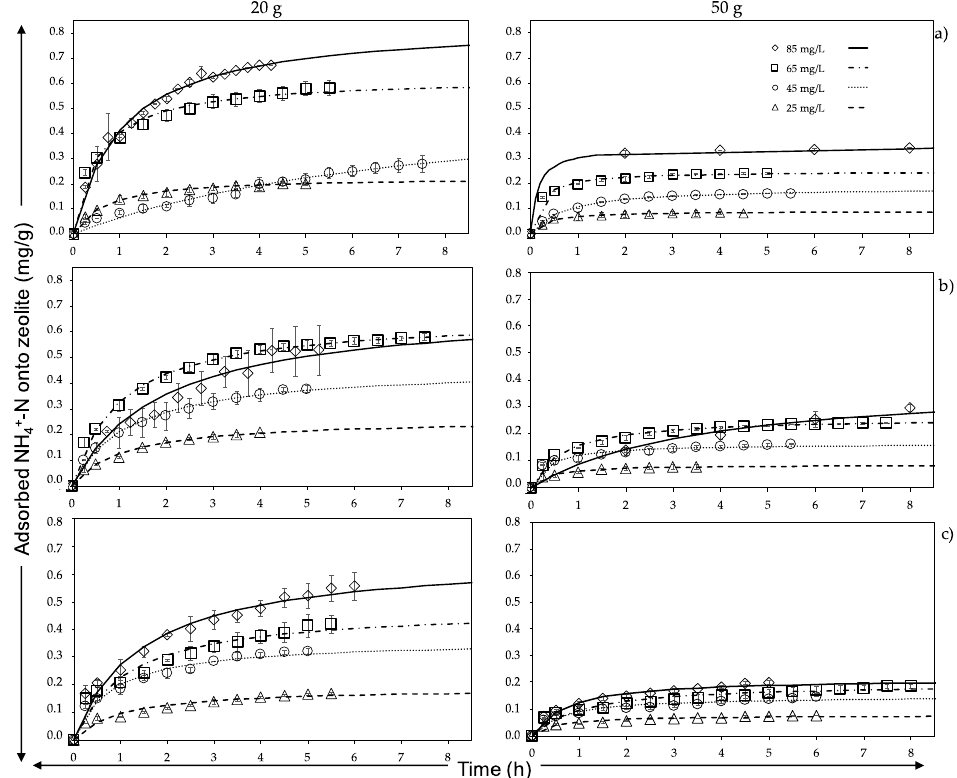
Figure 1. Adsorbed ammonium (mg / g) onto zeolite vs. time in batch assays for the determination of adsorption characteristics. Particle size: ( a ) 5.0–8.0 mm; ( b ) 1.5–3.0 m; and ( c ) 0.2–1.0 mm.